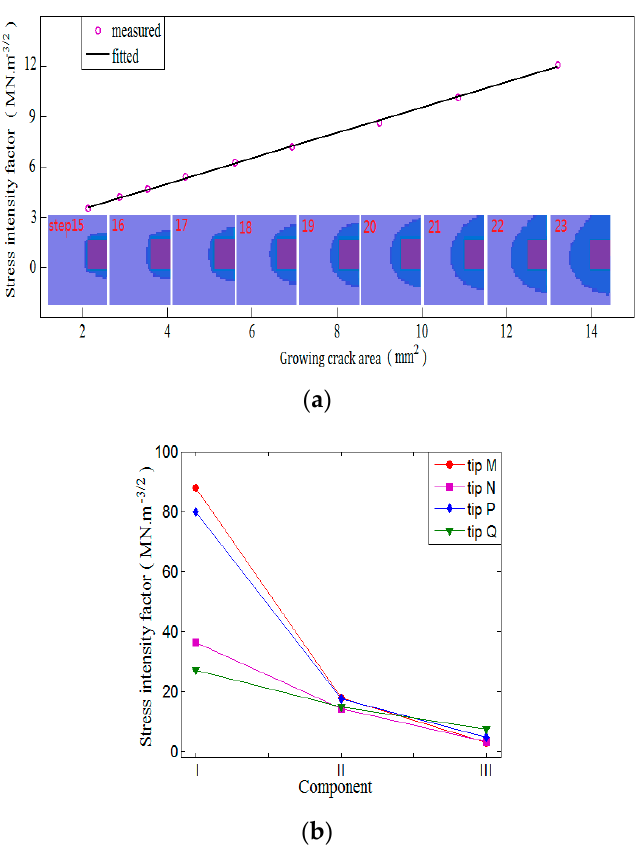
Figure 5. Stress intensity factor (SIF): ( a ) Validation; ( b ) comparison of crack tips.